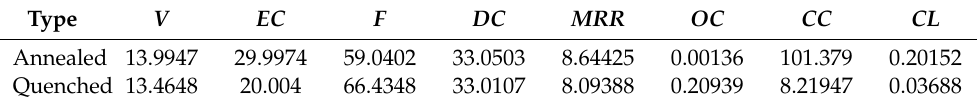
Figure 11. Convergence plot of ABC algorithm ( a ) Annealed; ( b ) Quenched. Table 12. Optimum parameter values for annealed and quenched process.